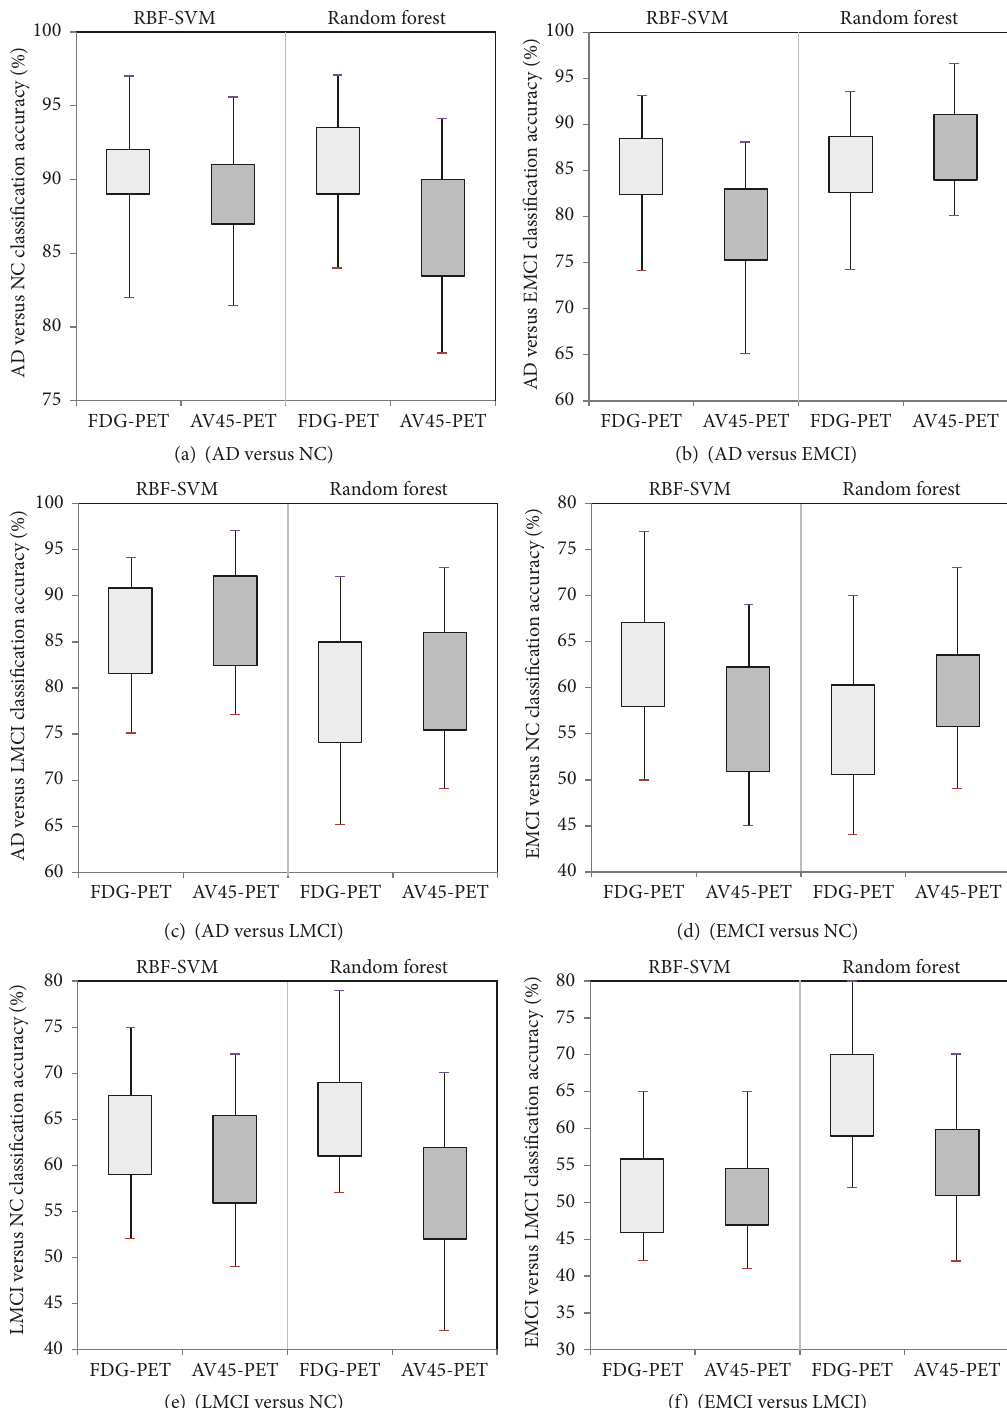
Figure 5: Box-plot figures of classification accuracies using multiregion approach between FDG-PET and AV45-PET, combining baseline and second-visit timepoints for all diagnostic